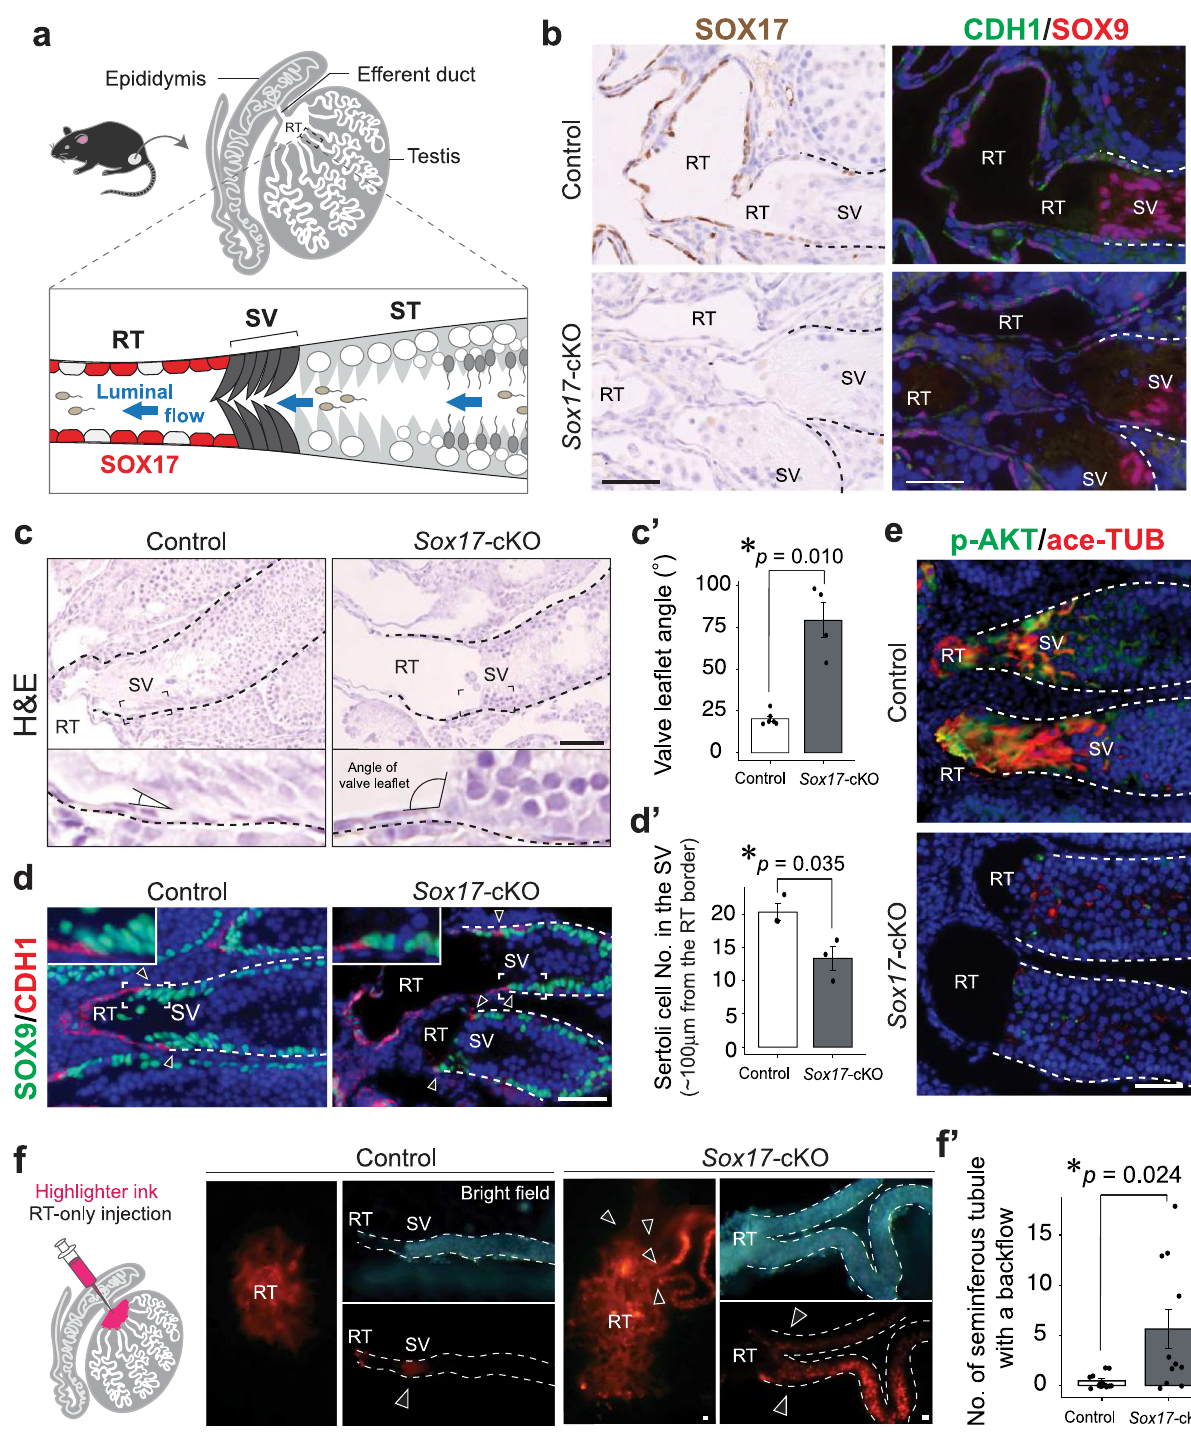
Fig. 1 | Deformation of the SV in Sox17- cKO mice. a Schematic illustration of the RT, SV, and ST. b SOX17, SOX9 (Sertoli cell & RT marker), and CDH1 (RT marker) immunostaining of two serial sections showing the RT-SV junction at 4 weeks of age. c H&E staining showing disrupted geometry of the SV, with an increase in the valve lea fl etangleseenin4-week-old Sox17- cKO mice( c ′ ).Control n =6. Sox17- cKO n =4. d SOX9andCDH1immunostainingshowingreducedSertolicelldensityinthe putative SV region in Sox17- cKO testis ( d ′ ). Control n =3. Sox17- cKO n =3. e SV- speci fi c signals of acetylated tubulin (ace-TUB) and phosphorylated AKT (p-AKT) immunoreactivity were decreased in Sox17- cKO mice compared to the controls. f SchematicillustrationoftheinjectionofdyeonlyintotheRT,andsurfaceviewsof